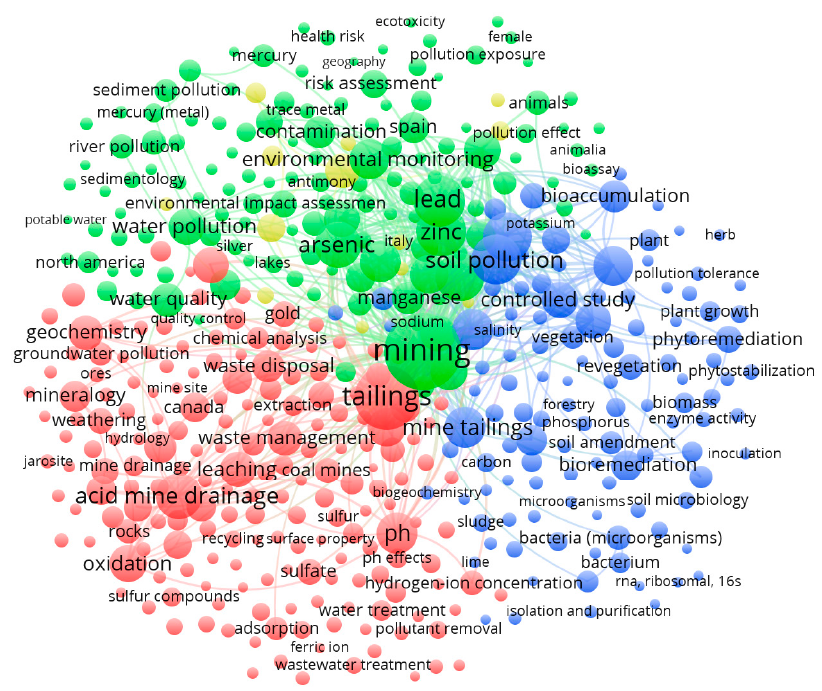
Figure 5. Main keywords’ co-occurrence network in MW research .